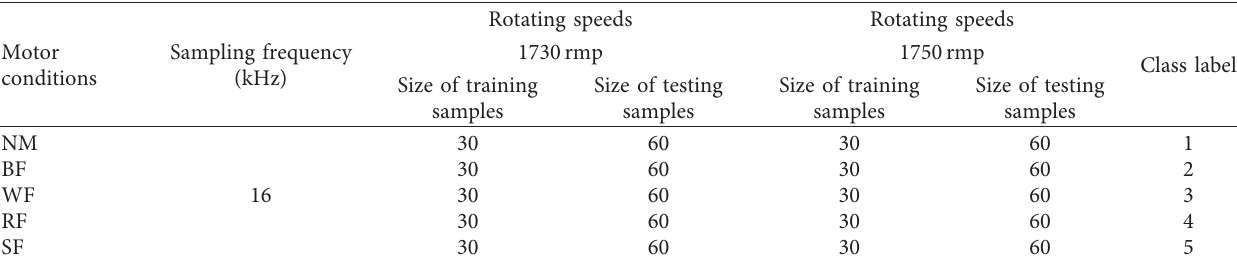
Table 2: Details about the motor vibration dataset.